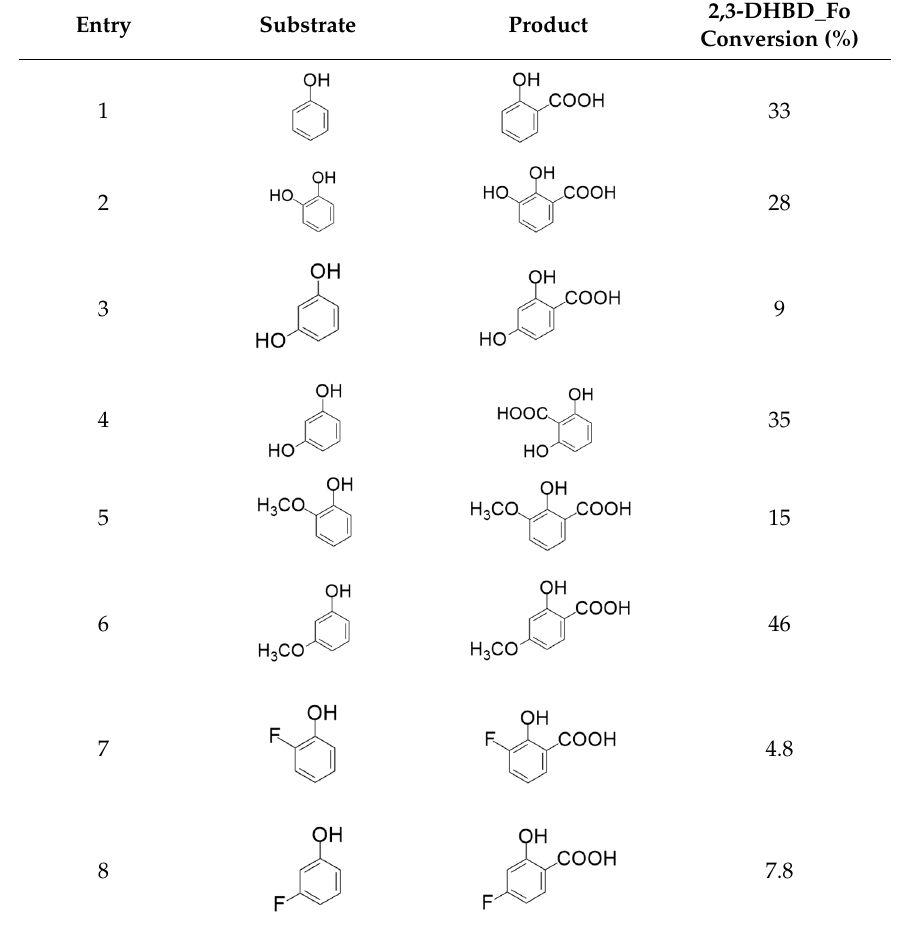
Table 6. Scope of the carboxylation reaction catalyzed by 2,3-DHBD_Fo (purified protein). Adapted with permission from [66]. Copyright 2018, Elsevier.